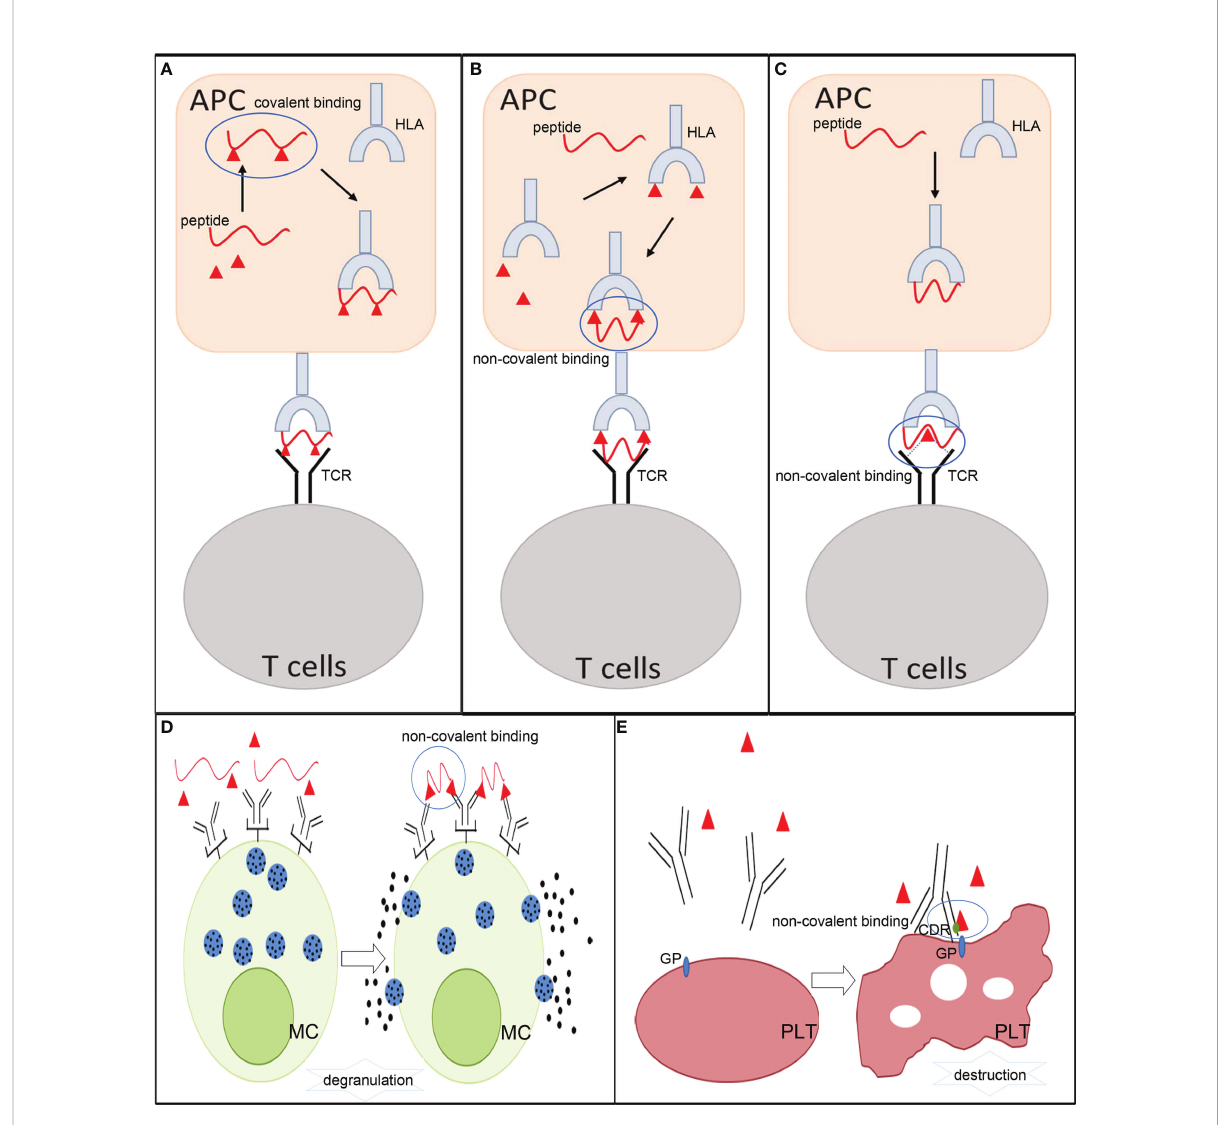
FIGURE 2 The mechanisms involved in allergic hypersensitivity reactions to small molecule drugs. (A) Hapten theory. (B) Altered peptide model of p-i HLA and allo-immune model of p-i HLA. (C) p-i TCR model. (D) Fake antigen model. (E) Drug-induced immune thrombocytopenia. APCs, antigen- presenting cells; HLA, human leukocyte antigen; TCR, T-cell receptor; MC, mast cells; PLT, platelets; GP, glycoprotein; CDR, complementary- determining